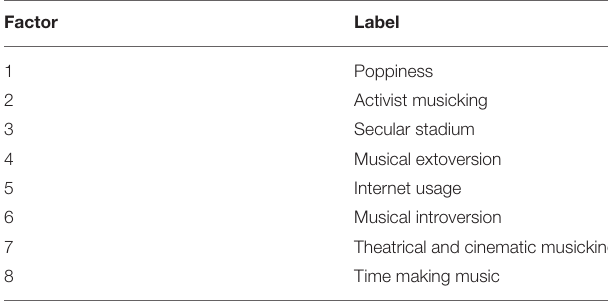
TABLE 5 | Interpretive labels for each factor.